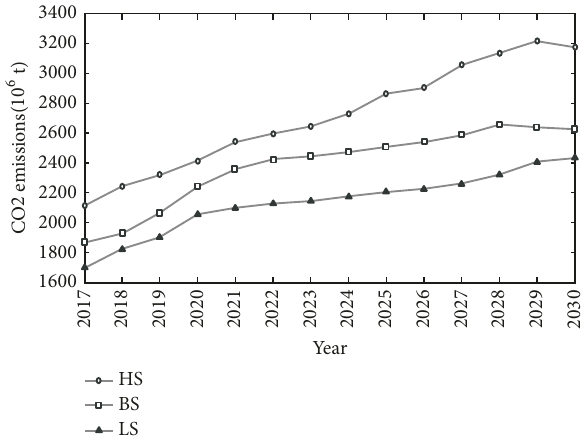
Figure 2: Predicted CO 2 emissions in China’s constructionindustry under three scenarios from 2017 to